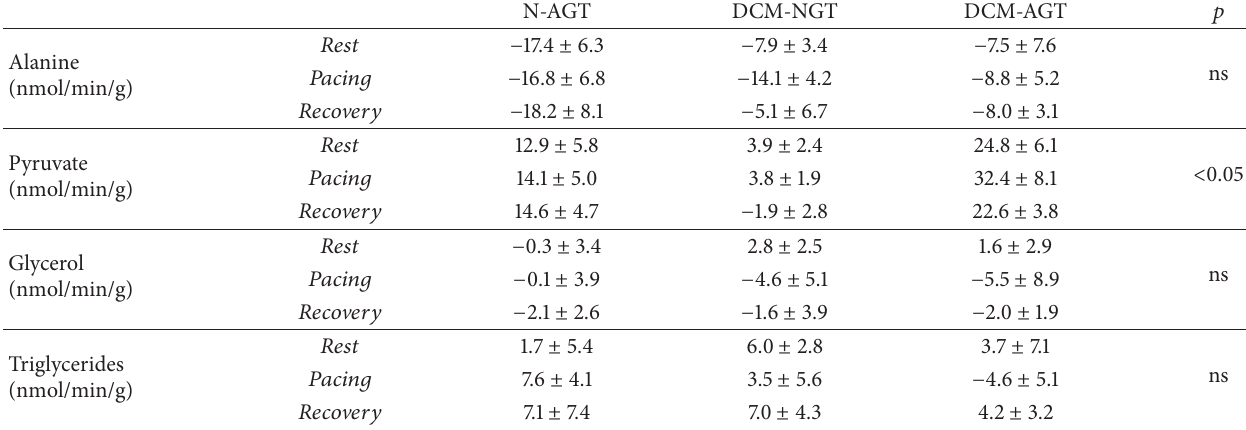
Table 2: Cardiac net balances of other